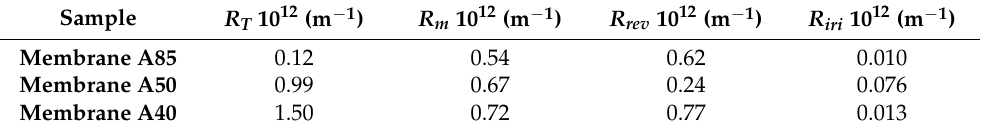
Table 6. Determination of the different values of the resistances according to the series resistance model.